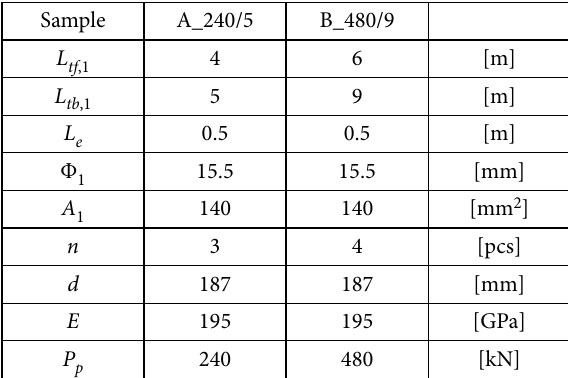
Table 2. Geometrical and mechanical properties of analyzed ground